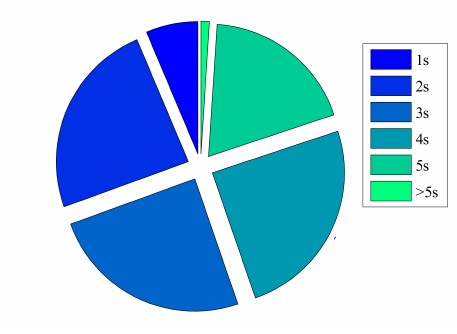
Figure 9. Service Execution